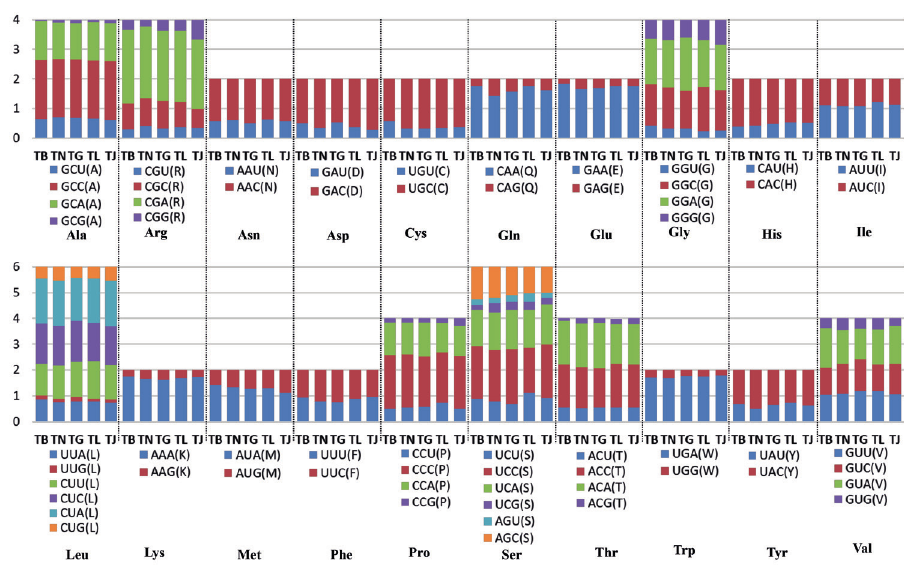
Figure 8. Relative synonymous codon usage (RSCU) of the mitogenomes of the five Trichiurus species; the stop codon is not included. T. japonicus (TJ), T. lepturus (TL), T. nanhaiensis (TN), T. gangeticus (TG) and T. brevis (TB).